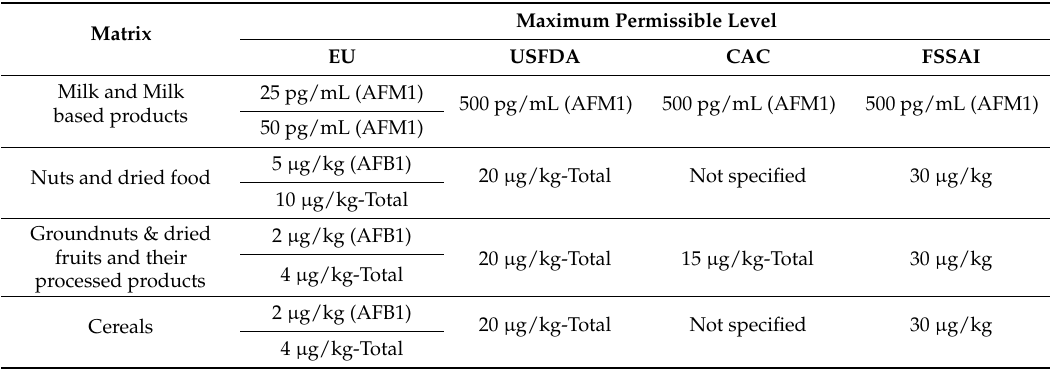
Table 1. The regulatory standard for aflatoxins